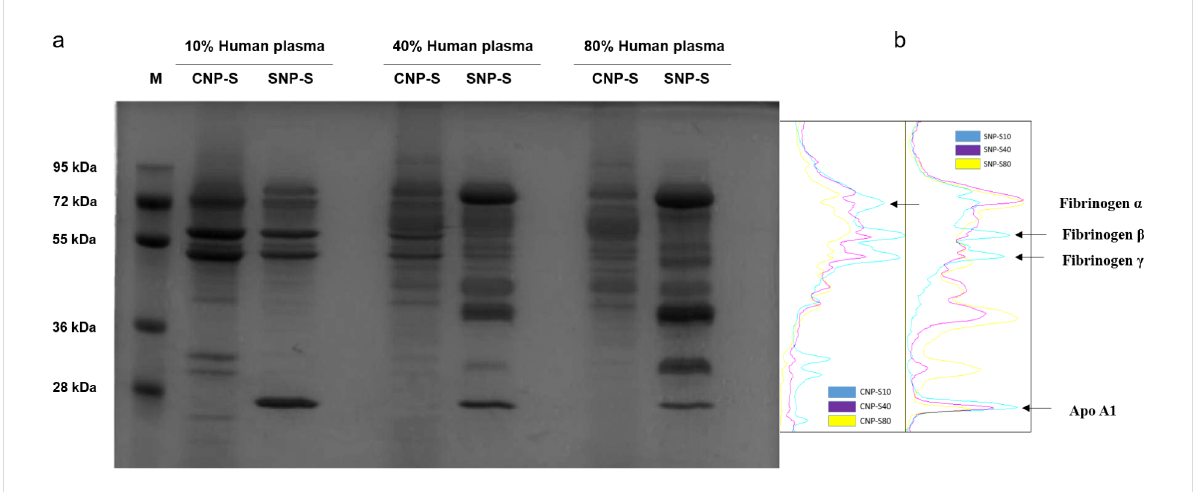
Figure 3: a) SDS-PAGE gel of hard protein corona formed after 1 h of incubation in human plasma. b) Densitometry of the gel bands corresponding to fibrinogen and apolipoprotein A1.